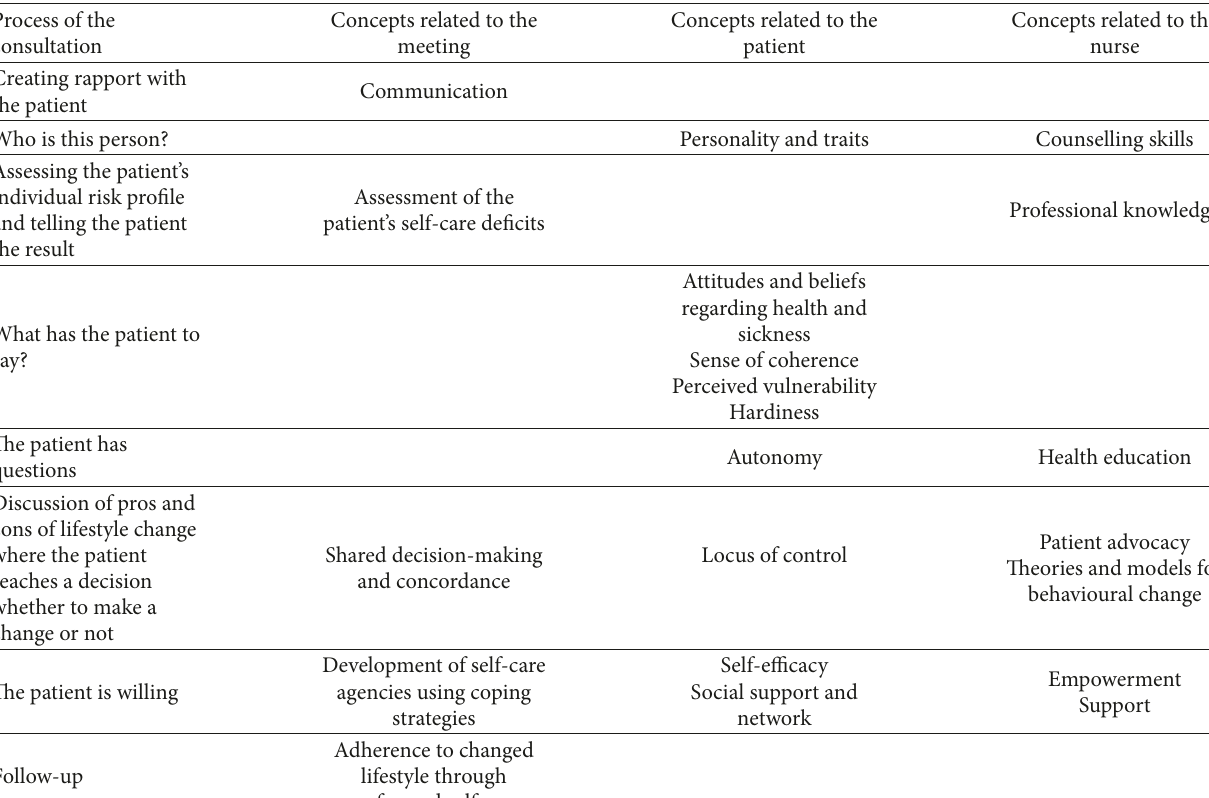
Table 2: A schematic description of how the nurse could make use of the proposed theory in hypertension care. All counselling sessions with patients need not follow the same order, and one concept is not used just at one particular time; for example, communication and professional knowledge are used throughout the consultation. The treatment mentioned here is lifestyle